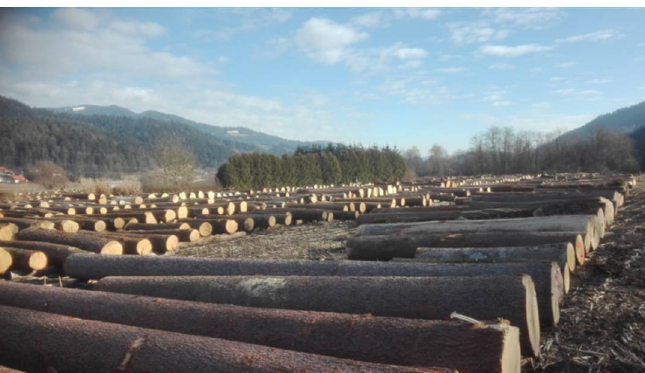
Figure 1. Valuable spruce logs and logs of other wood species on display at the auction field.